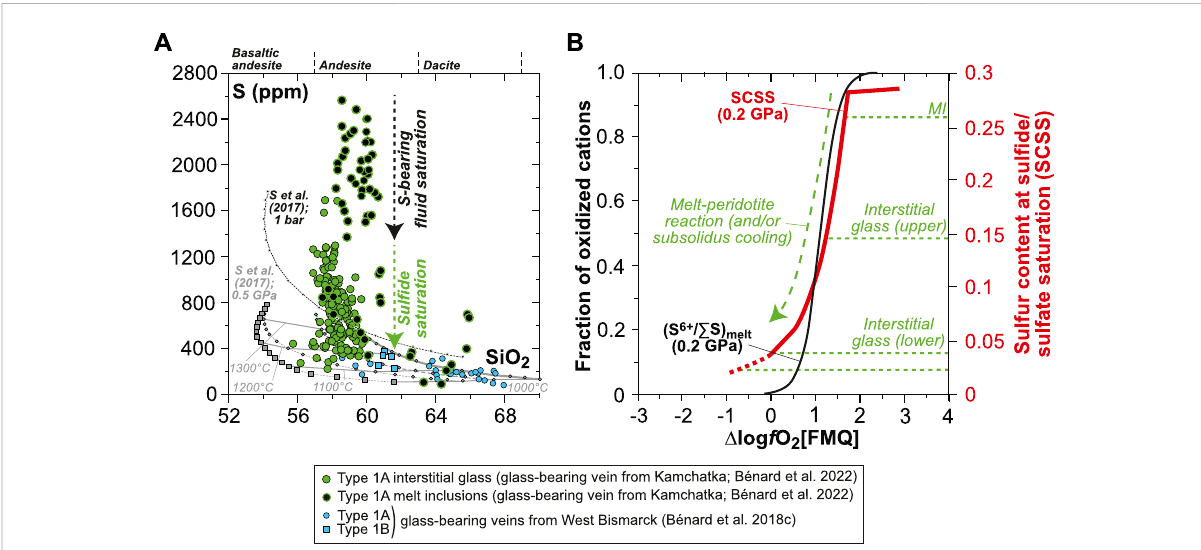
FIGURE 1 Sulfur composition and inferred S 6+ / (cid:1) S (S 6+ /(S 6+ +S 2 − )) in silicate melts for the glass-bearing Type 1A veins from Kamchatka and Type 1A and Type 1B veins from West Bismarck (Bénard et al., 2018c; Bénard et al., 2022). (A) S abundances measured by EPMA and SEM in vein MI and interstitial glassplottedagainstSiO 2 (inwt%).Also,SCSScalculatedwiththemodelofSmytheetal.(2017)at1 barand0.5 GPa(blackandgraylines,respectively) are shown. Melt major element compositions used to calculate SCSS are those of isobaric models for the liquid lines of descent of spinel harzburgite – derivedmelts(i.e.,LCB)at1 GPa,calculatedbyBénardetal.(2018c)withpMELTS(Ghiorsoetal.,2002). (B) PlotofS 6+ / (cid:1) Sinsilicatemelts (S 6+ / (cid:1) S melt ;blackcurves)against Δ log f O 2 [FMQ].TheS 6+ / (cid:1) S melt curvesarederivedfromexperimentsat0.2 GPa(Jugoetal.,2010;Klimmetal.,2012). Also shown in (B) are the SCSS in experimental andesitic melt at 0.2 GPa (red curve; Botcharnikov et al., 2011) and the highest S abundances measuredintheMI,aswellastheupper-andlower-endSabundancesmeasuredintheinterstitialglassfromtheKamchatkavein(dottedgreenlines; Bénard et al., 2022). The decrease in S abundances from MI to the interstitial glass is triggered by S capture in high-T, hydrothermal fl uids, and magmatic sul fi de saturation, concomitant with a decrease in the oxidation state from Δ log f O 2 [FMQ]~+1.5 to − 1 ≤ Δ log f O 2 [FMQ] ≤ 0 due to a S 6+ -Fe 2+ redox exchange during melt-rock reactions (dotted and dashed arrows in (A) and (B)